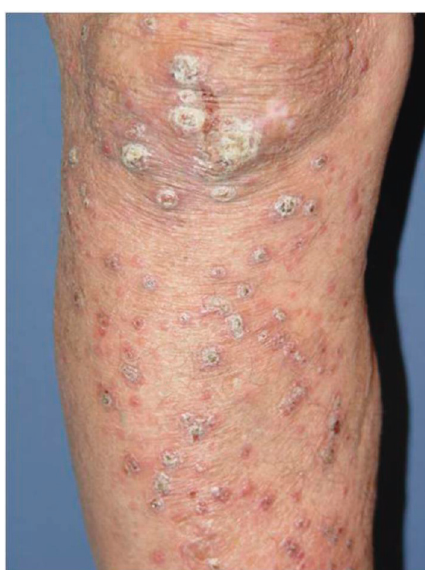
Figure 6: Lepromatous leprosy: skin lesions resembling guttate psoriasis, prurigo nodularis, or hypertrophic lichen planus (pho- tograph courtesy of Kundakci, et al.)